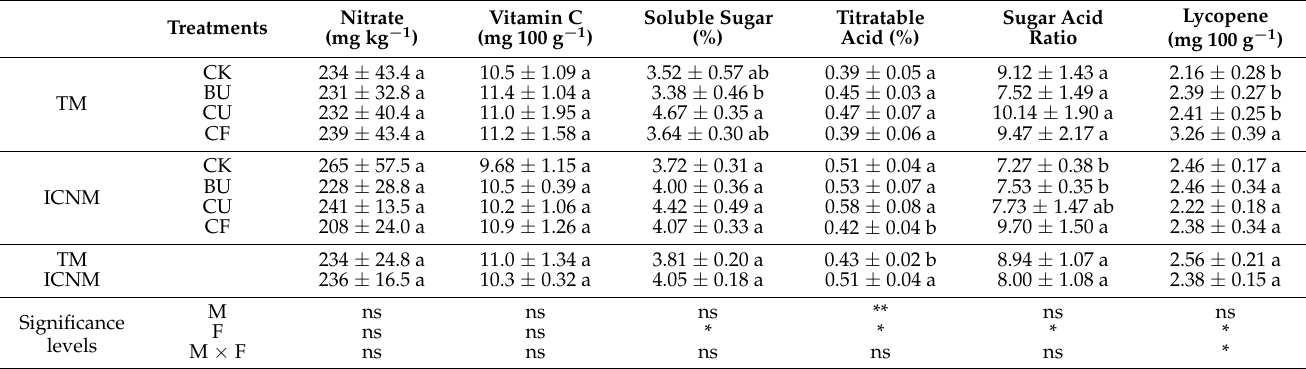
Table 3. Effects of different treatments on fruit quality of tomato.